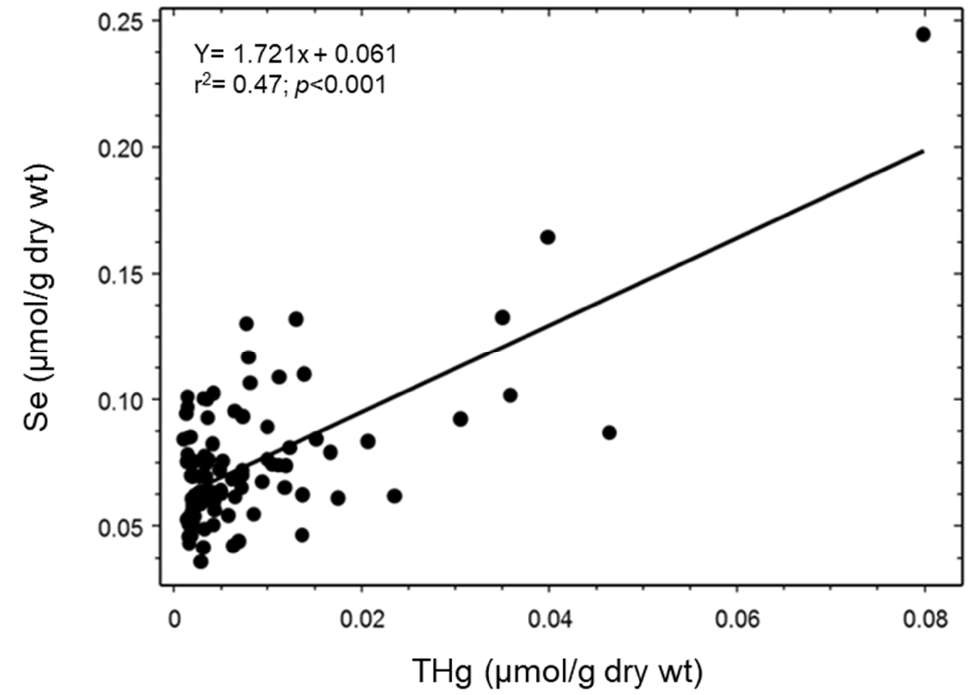
Figure 2. Relation between the concentrations of total selenium (Se) and total mercury (THg) in livers of northern pike (F 1,92 = 80.10; p < 0.001; r 2 = 0.47 ; n = 94). Se concentrations ranged from 2.83 µg/g to 19.30 µg/g dry wt (mean = 5.95 ± 2.28),